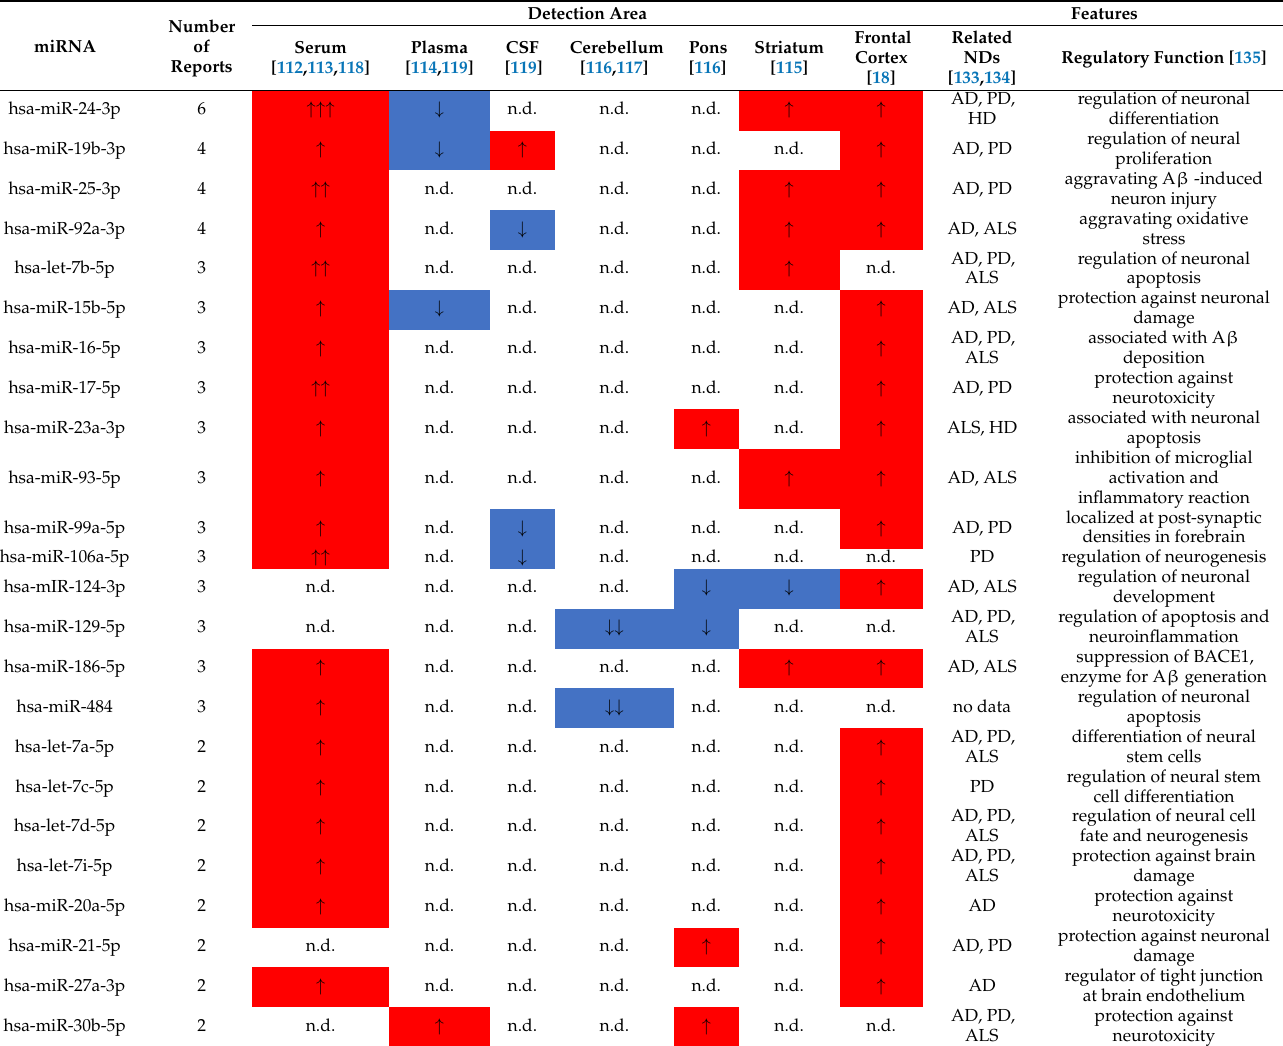
Table 2. List of miRNAs that are upregulated or downregulated in patients with MSA reported in two or more studies. Detection Area